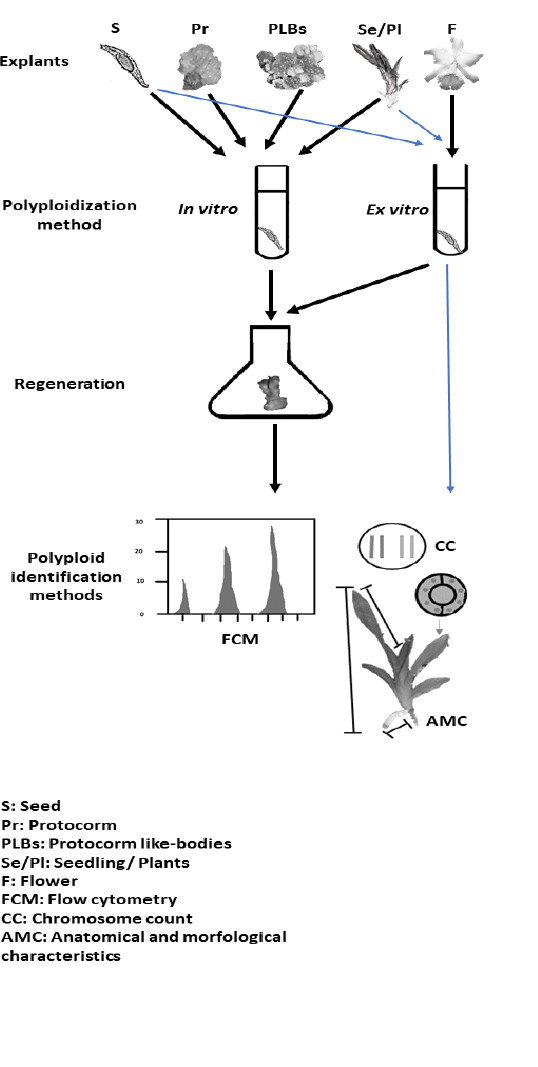
Figure 1. Workflow of the treatment of different types of explants with antimitotic agents aiming to obtain polyploid plants in orchids (left) and morphological differences between autopolyploid plants of hybrid Cattleya orchids induced by treatment with colchicine and confirmed by flow cytometry ( A , B ) and plants not induced ( C , D ). Table 2. Polyploidy induction of Cattleya using antimitotic